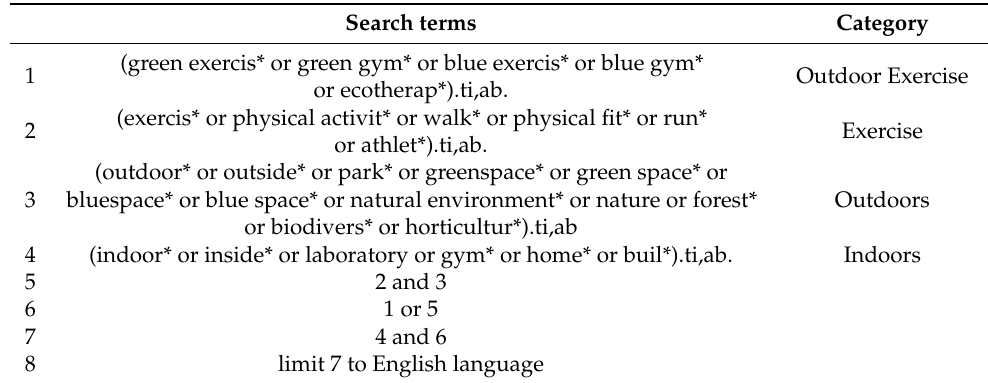
Table 1. Master search strategy. Shown is the strategy designed in Ovid MEDLINE and adapted for other databases. *: indicates truncation to capture multiple suffices of the base search term.